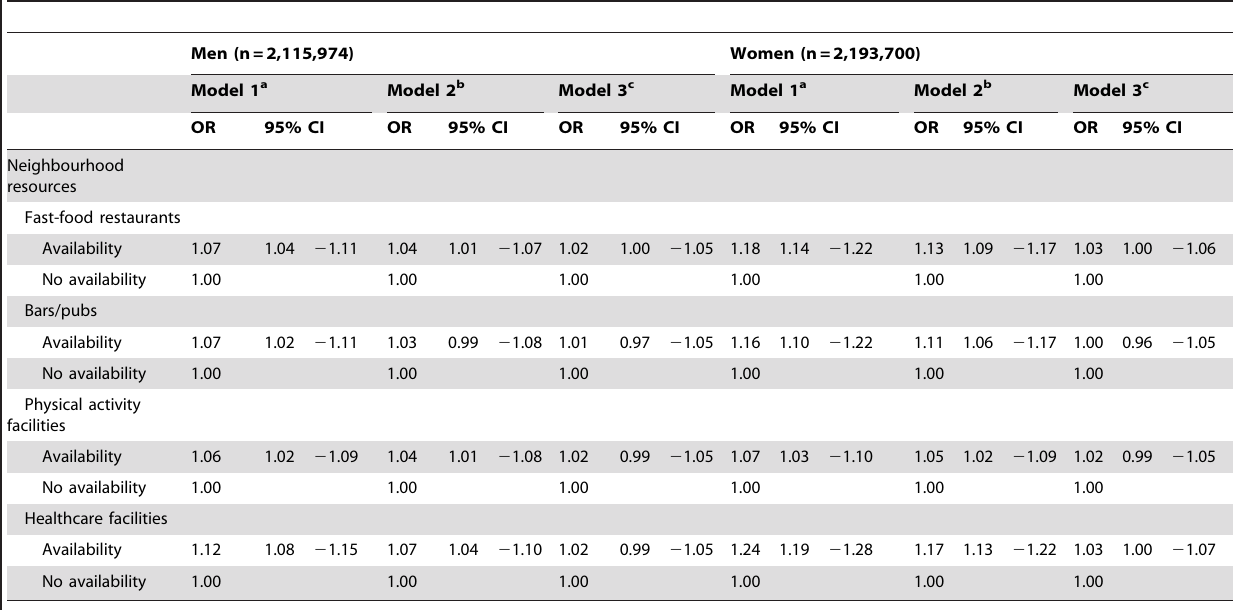
Table 2. Associations between stroke and neighbourhood availability of potentially health-promoting and health-damaging